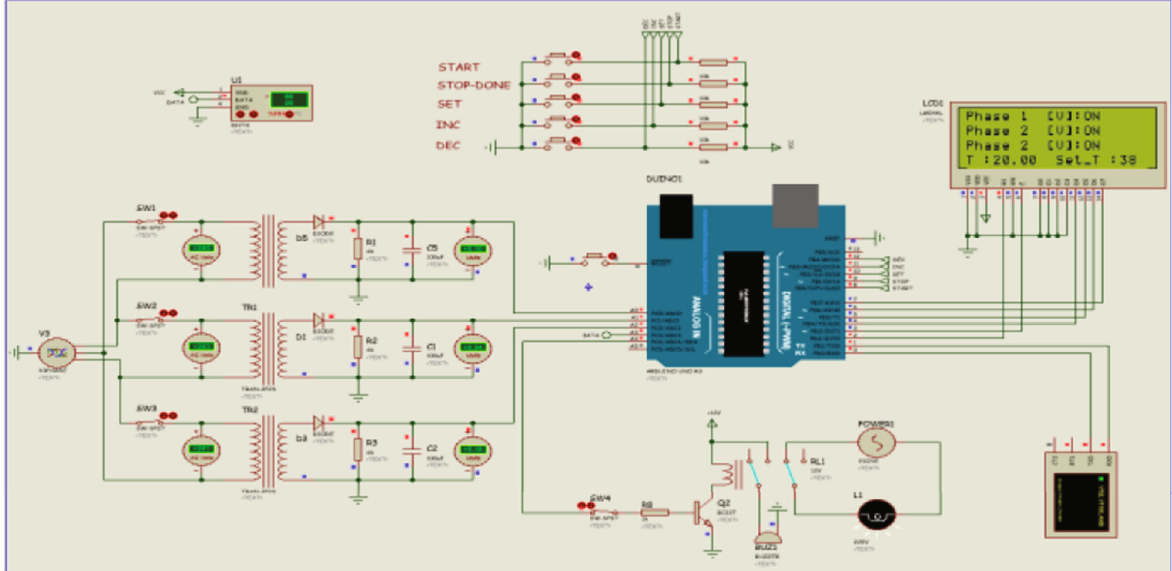
Figure 3: Simulation model of single phasing and overtemperature by using Arduino.